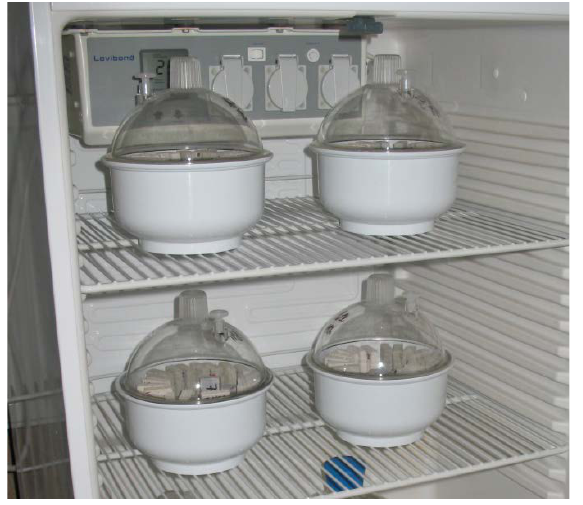
Figure 6. Desiccator method for measurement of the equilibrium moisture content at given relative humidity of environment. humidity of environment.